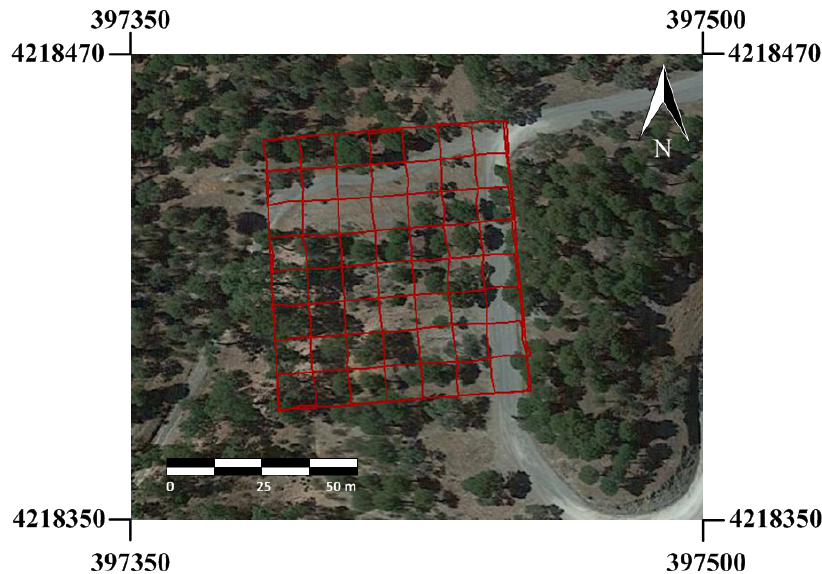
Figure 3. The flight path in the study area (coordinates (m): UTM zone 30N referred to